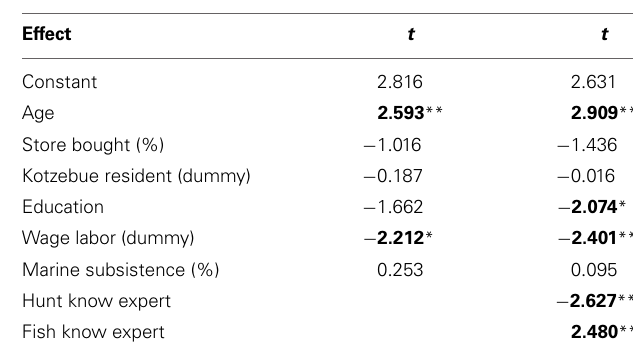
Table 3 | Multiple regression for Climate Change Knowledge Index (CCKI) as dependent variable with models using demographic and non-network independent variables (Model 1; R 2 = 0 . 279) and a model including network independent variables (Model 2; R 2 = 0 .